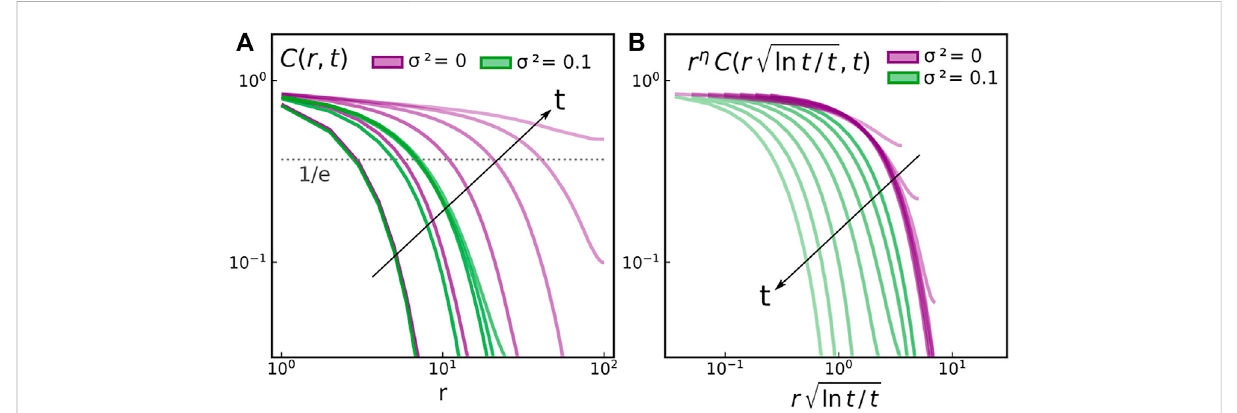
FIGURE 2 Time evolution of (A) the space correlation function C ( r , t ) at different times t ≈ 4, 20, 100, 400, 2000, 10000 (B) the rescaled correlation function ( η = T /2 π from thespin-wave theory) against therescaled time.In bothpanels, thepurple curves correspond to theXYmodelat T = 0.4 and the green curves correspond to a forced system at T = 0.4 and σ 2 = 0.1. Longer times are represented by lighter colors, as the arrows indicate.